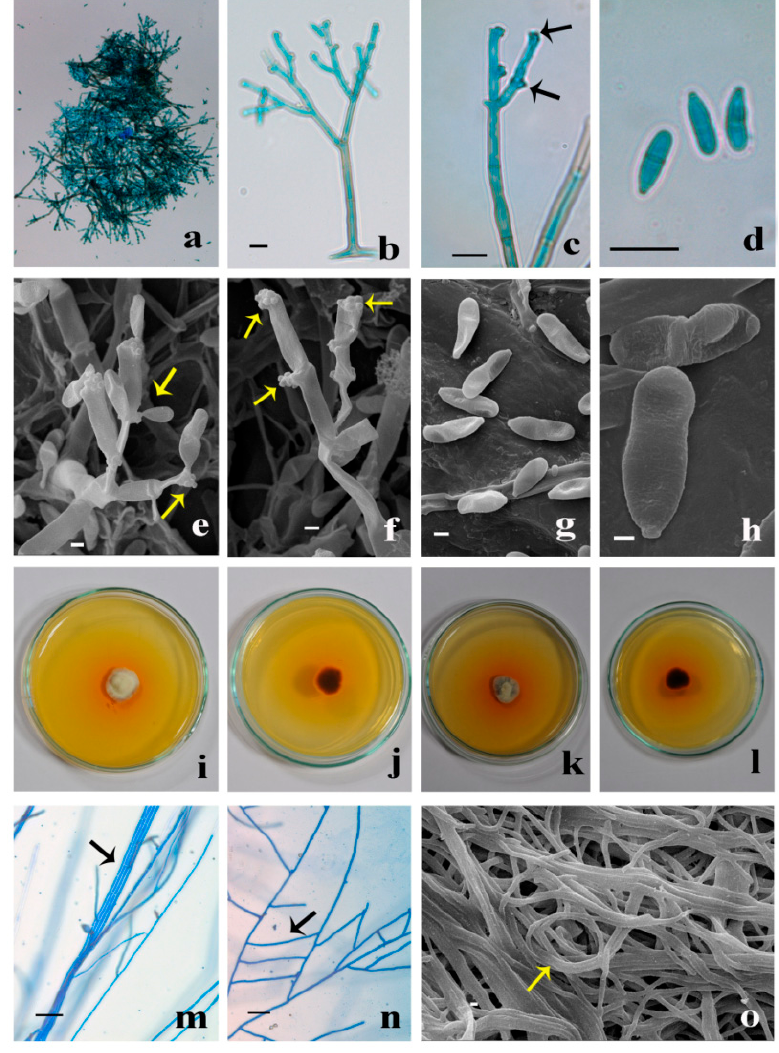
Figure 1. Gonatophragmium triuniae (NFCCI 4873): ( a ) Numerous conidiophores in low magnification; ( b ) Single dichotomously branched conidiophore; ( c ) Conidiophore and conidiogenous cells bearing dark scars (showing arrows); ( d ) Numerous conidia in high magnification; ( e ) SEM of conidiophores with attached conidia; ( f ) SEM of conidiophore bearing intercalary and terminal conidiogenous cells with dark scars (showing arrows); ( g , h ) SEM image of conidia; ( i – l ) Colonies of G. triuniae NFCCI 4873 on PDA and PCA (front and reverse view); ( m , n ) Hyaline sterile hyphal bundle and anastomosis in-vitro culture (showing arrows); ( o ) SEM of sterile hyphal bundles with coiling (showing arrow).